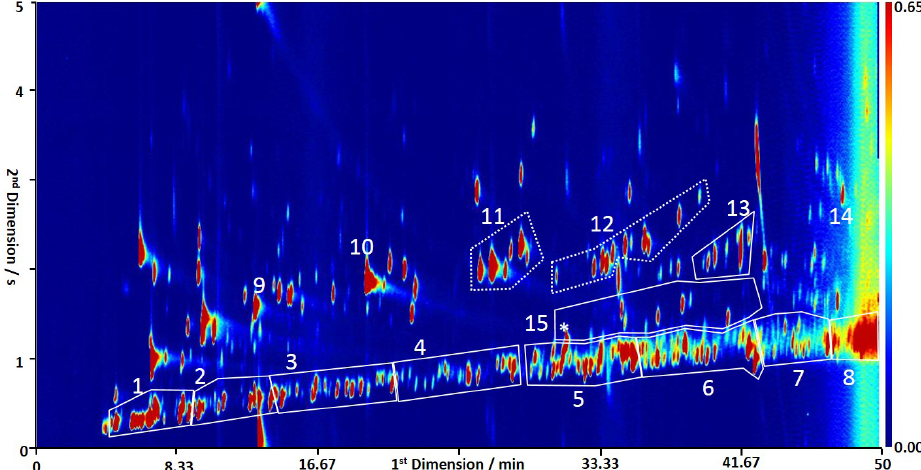
Figure 2. Typical GC × GC-FID chromatogram from 25 July 2012, demonstrating the grouping of compounds. The retentions on the first and second columns are the x and y axis respectively, with the intensity of the compound shown by the coloured contours. Labelled peaks and groups are identified as follows, with the dashed and solid lines indicating compounds that were identified individually and as a group respectively; (1–8) aliphatic groups from C 6 to C 13 , (9) benzene, (10) toluene, (11) C 2 substituted monoaromatics, (12) C 3 substituted monoaromatics, (13) C 4 substituted monoaromatics, (14) naphthalene, and (15) C 10 monoterpenes with * corresponding to α -pinene which is the start of that group. The remaining compounds, not enclosed in a box contain hetero-atoms, primarily oxygenates. The grouping of compounds was accomplished using the lasso technique in Zoex GC image software (Zoex, USA). This technique allows the software to calculate the area of all peaks included in the